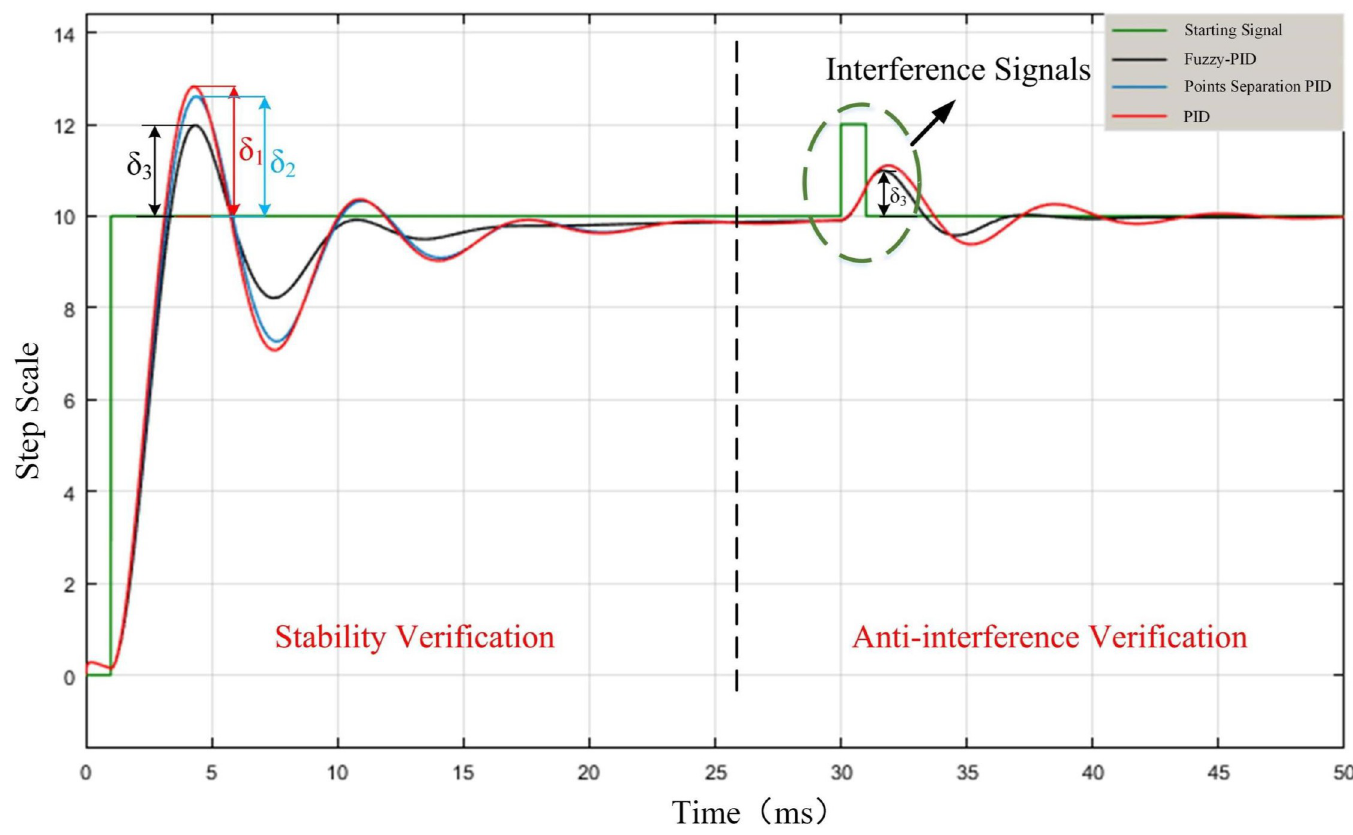
Fig 16. Interference signal